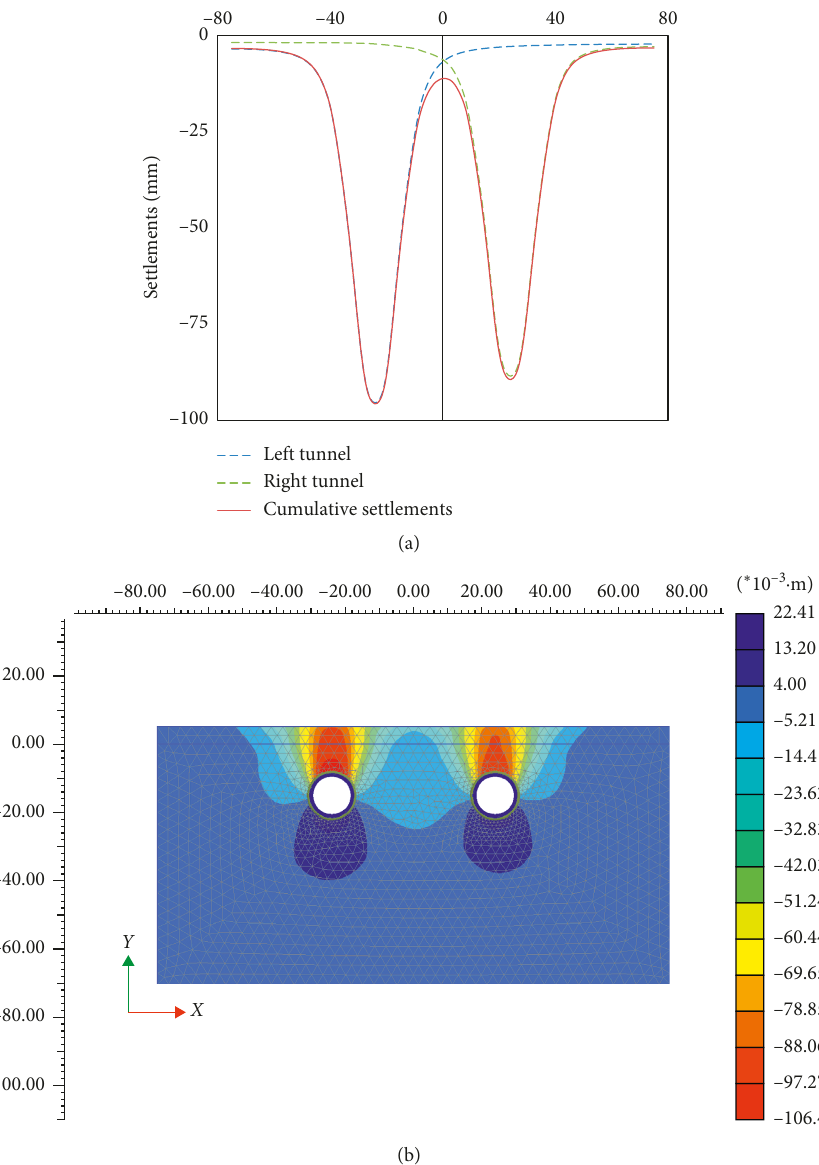
Figure 11: (a) Settlement trough equivalent horizontal twin tunnels ( u � 3 D ). (b) Displacement contours resulting from equivalent horizontal twin tunnels ( u � 3 D